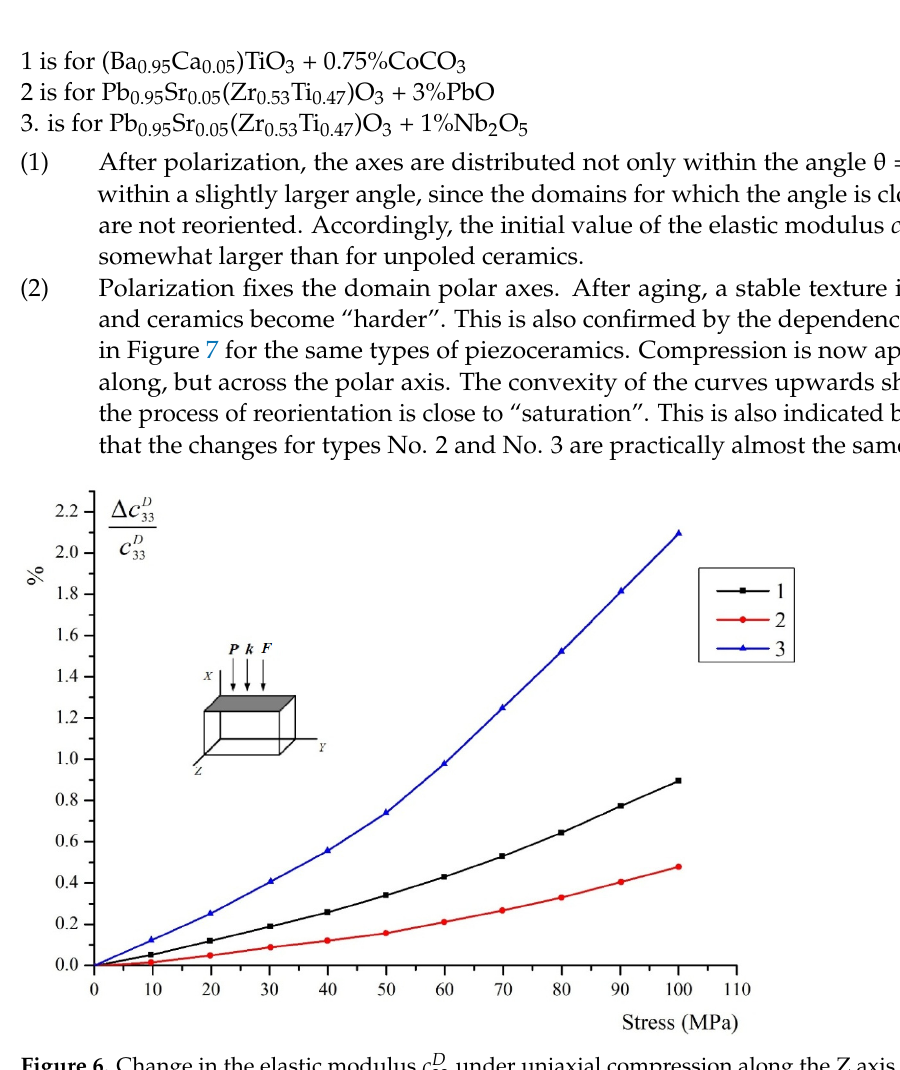
Materials 2022 , 15 , x FOR PEER REVIEW